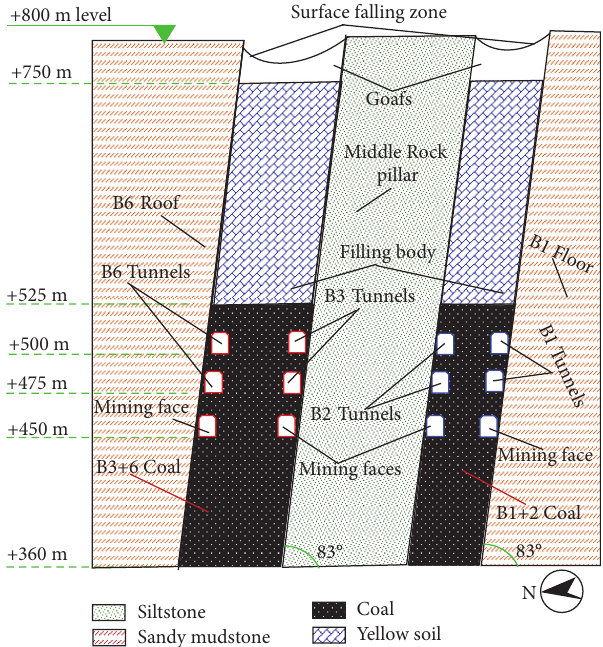
Figure 1: The profile of the Wudong coal